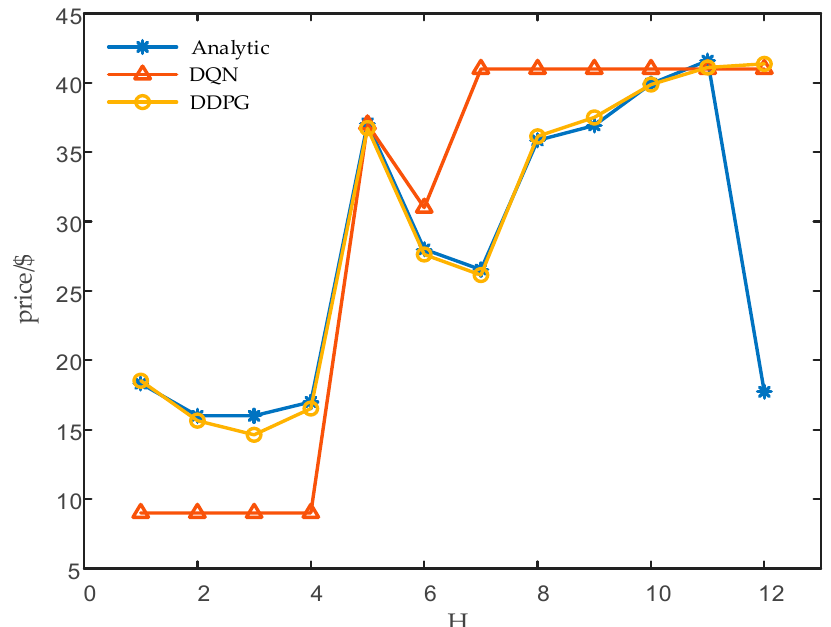
Figure 12. Energy sharing (ES) price at different time intervals under three methods. Energies 2020 , 13 , x FOR PEER REVIEW